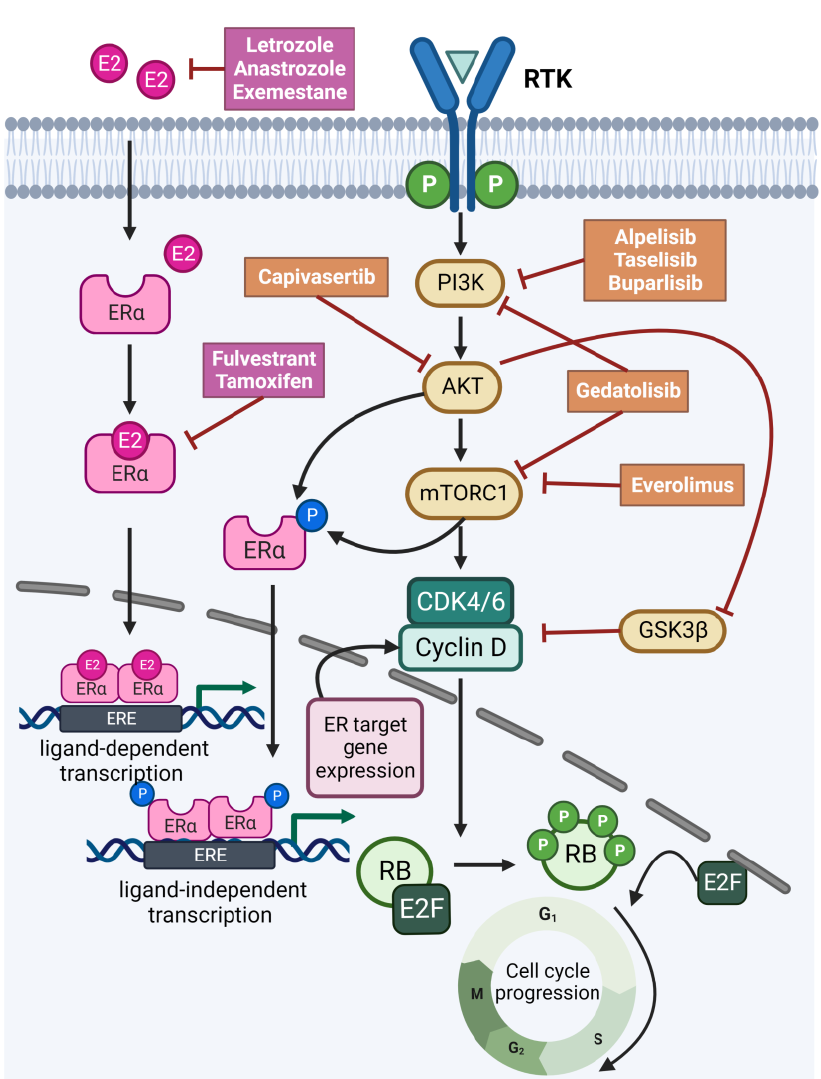
Figure 3. The convergence of the PI3K/AKT/mTOR, cyclin D-CDK4/6-RB and estrogen receptor pathways in ER+ breast cancer. Cyclin D1 functions as a common node by regulating the cell cycle through binding to CDK4/6, inducing ligand-independent activation of ER that can conversely induce cyclin D1 expression, which is further upregulated and stabilized by downstream effectors of the PI3K/AKT/mTOR pathway. Drugs targeting various regulators of the three pathways are also depicted. E2, estrogen; ER, estrogen receptor; ERE, estrogen response elements; RTK, receptor tyrosine kinase. Table 2. Clinical trials testing triple and sequential double combinations with inhibitors of the